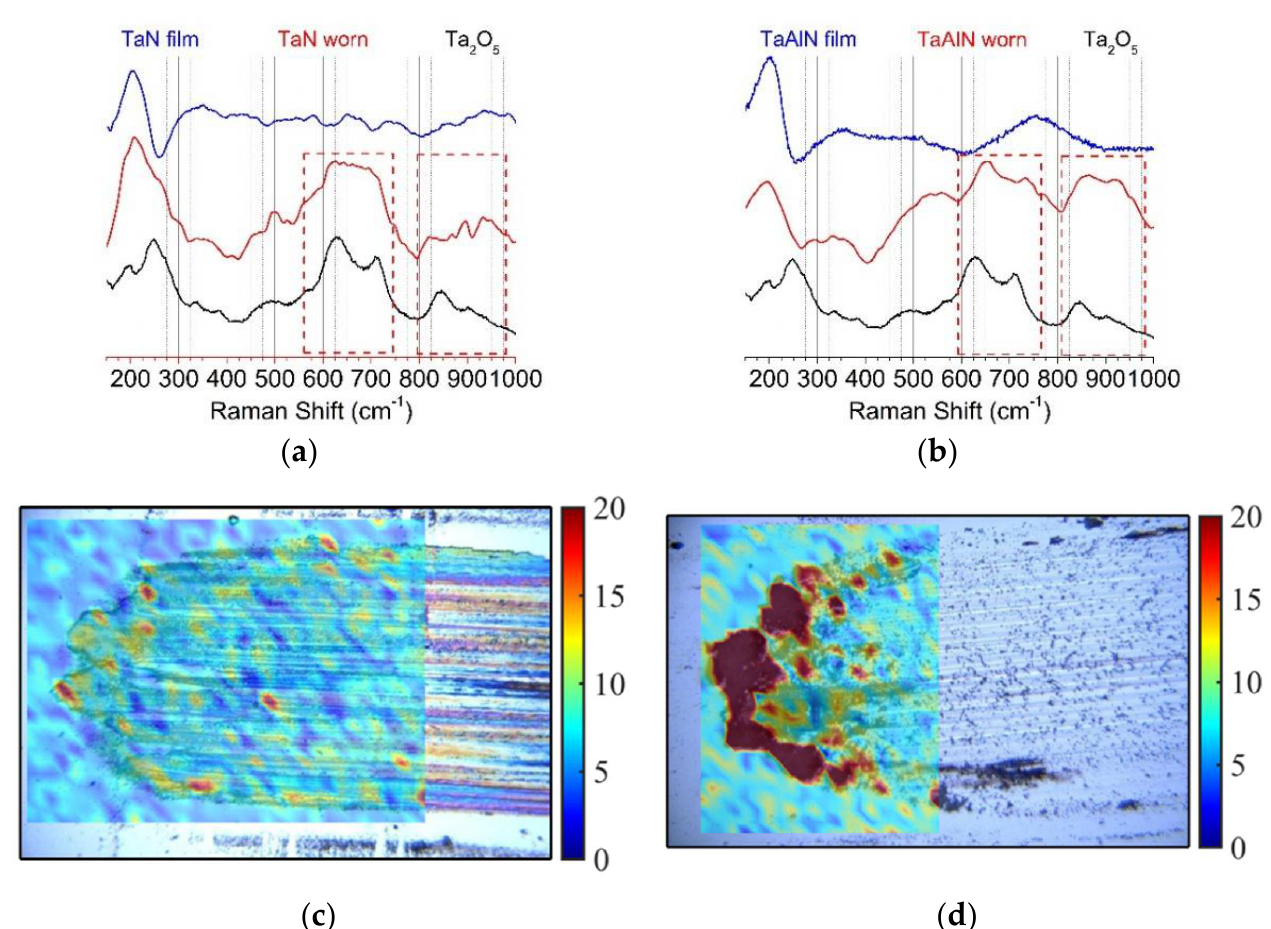
Figure 11. Raman spectra of ( a ) TaN3 and ( b ) TaAlN3 coatings for the as-deposited and worn films compared to the spectrum of Ta 2 O 5 . The most characteristic bands of Ta oxides are highlighted in the red boxes. ( c ) Ta-N and ( d ) Ta-Al-N film µ Raman maps on the scratched area, reporting, in false colors, the Raman intensity of the band of Ta oxide at 650 cm −1 .